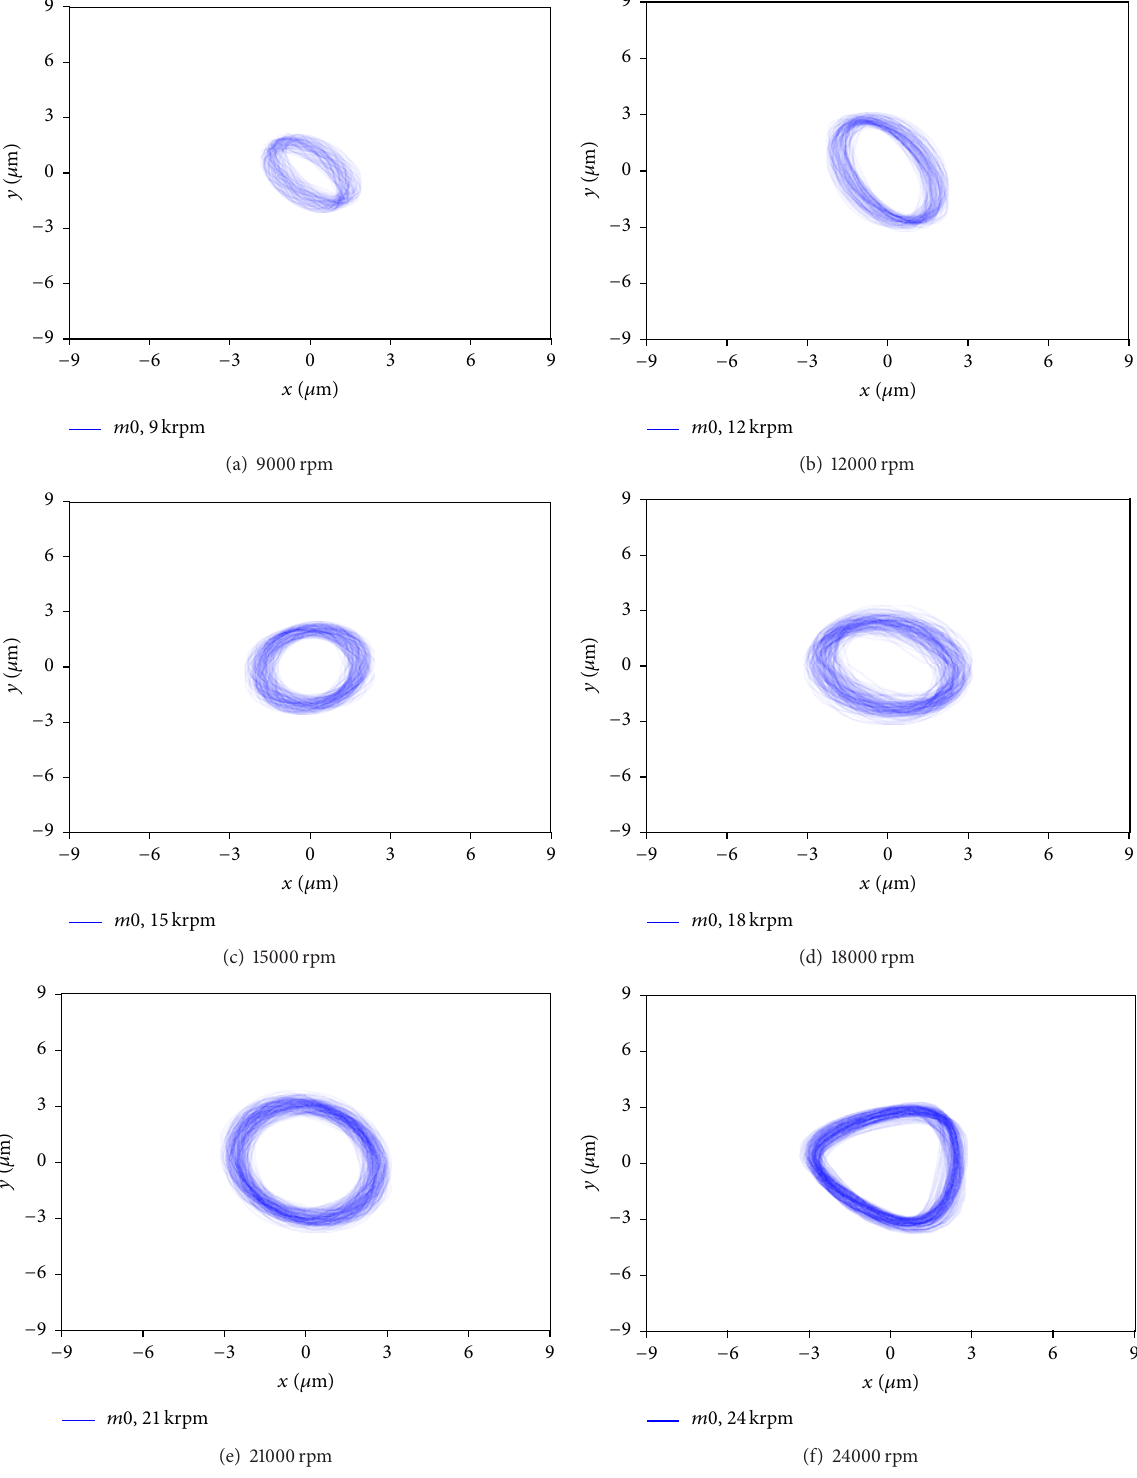
Figure 6: Orbits of the front bearing without attached unbalance